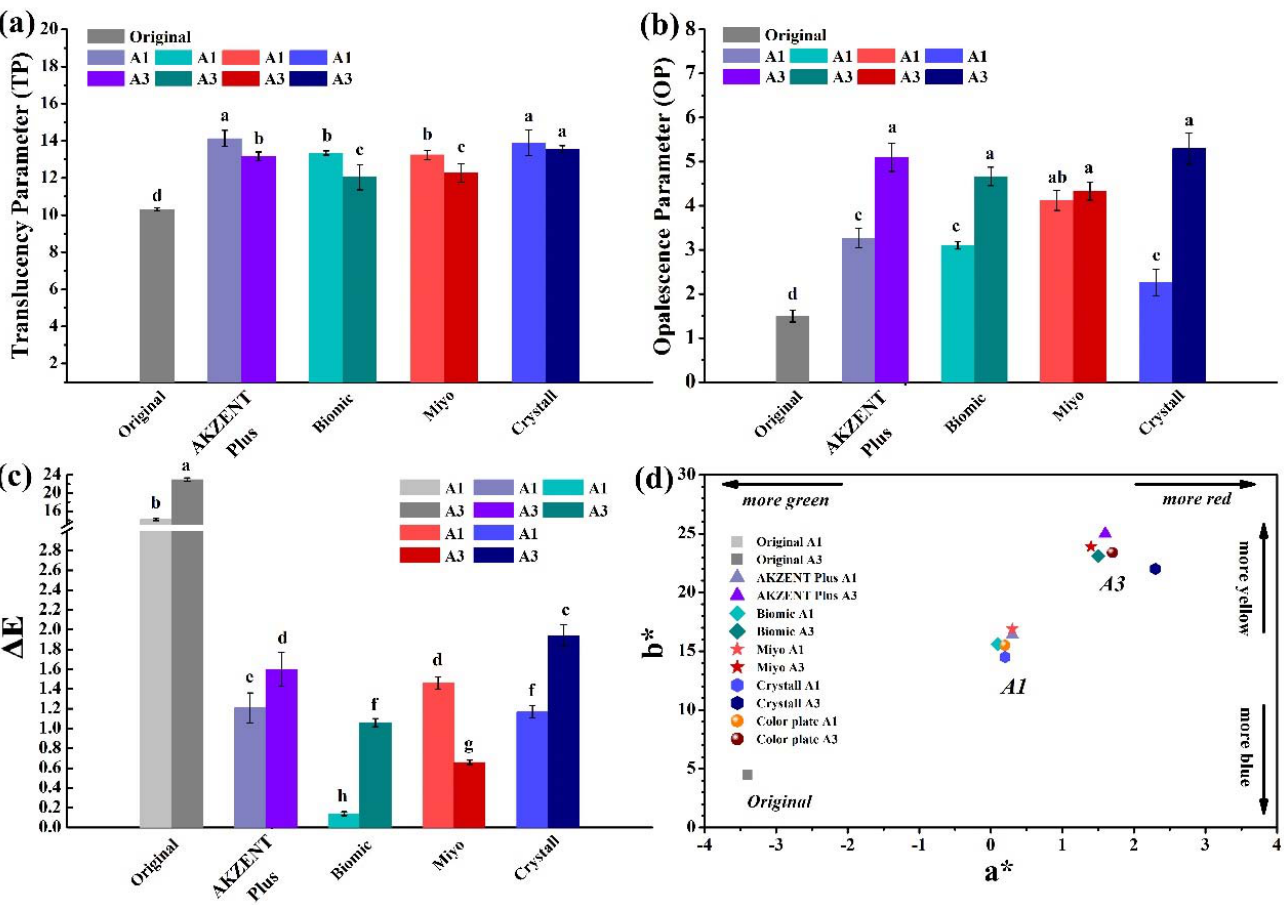
Figure 3. Optical properties of zirconia. ( a ) Translucency parameter (TP), ( b ) opalescence parameter (OP), ( c ) Δ E, and ( d ) coordinate distance. Means with different letters were significantly different ( p < 0.05, mean ± SD, n = 5).